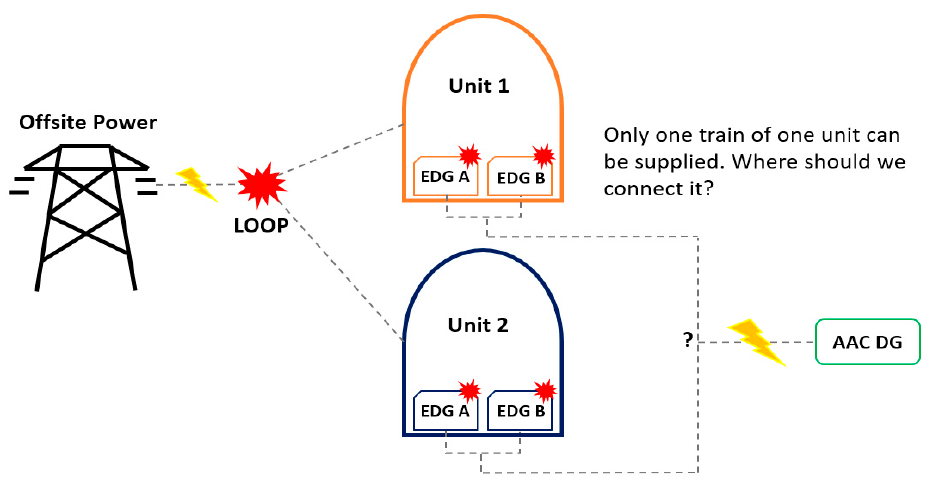
Figure 1. Difficulty in determining priority for an available AAC DG in a multi-unit SBO.